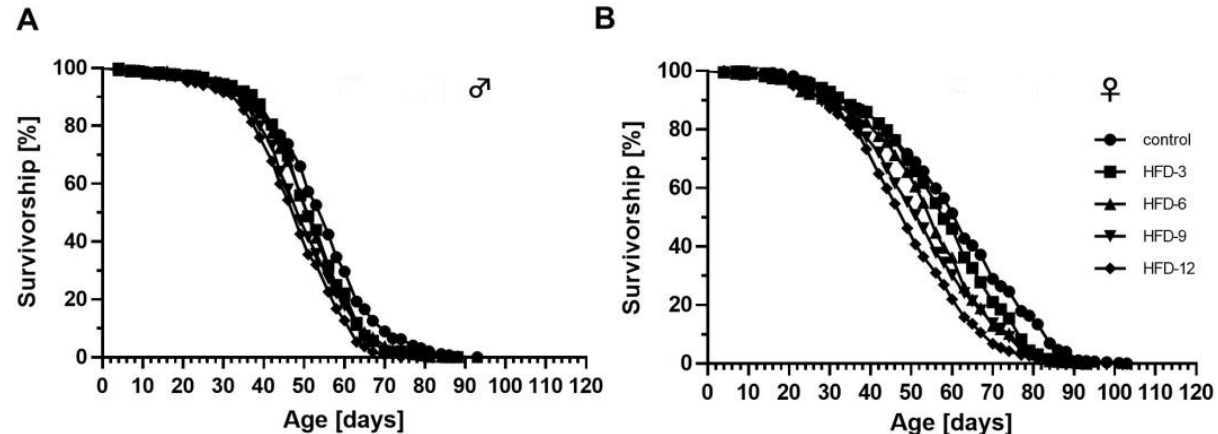
Figure 4. Lifelong ingestion of a high-fat diet (HFD) comprising 3–12% ( w / v ) butterfat (BF) reduced the lifespan of male and female D. melanogaster. ( A ) HFDs containing increasing concentrations of BF (3%, 6%, 9%, 12% ( w / v )) significantly reduced the lifespan of male and ( B ) female w 1118 flies compared to controls (Logrank p < 0.001; n = 3 with N = 450 animals per treatment; a merge of all three lifespans is shown). The corresponding median, mean and maximum lifespan data are listed in Table 1. HFD-3: HFD with 3% ( w / v ) BF, HFD-6: HFD with 6% ( w / v ) BF, HFD-9: HFD with 9% ( w / v ) BF, HFD-12: HFD with 12% ( w / v ) BF. Table 1. The impact of increasing concentrations of dietary butterfat on the lifespan data for male and female fruit flies. The median, mean and maximum lifespan data for male and female w 1118 fruit flies fed a control sugar yeast (SY) diet are listed as the mean values ± SEM in days (d) (for each sex n = 3; N = 450 animals). The percentage differences from these values in response to increasing BF concentrations are shown.